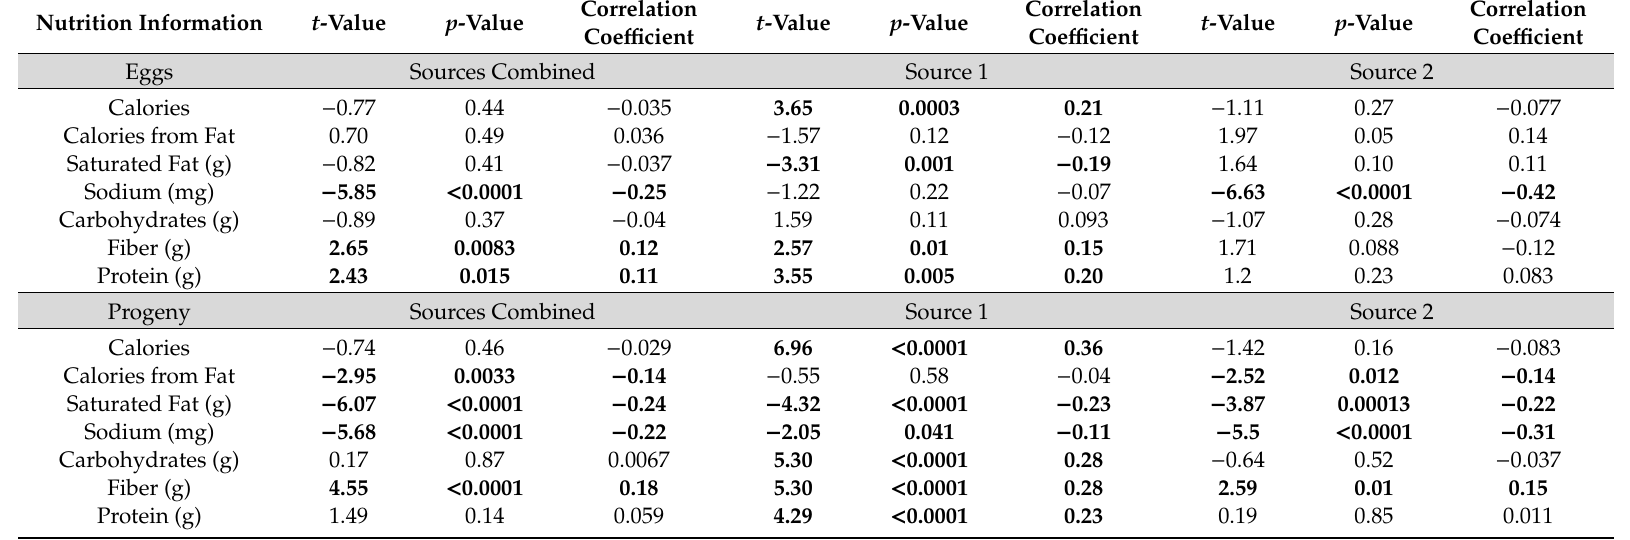
Table 4. Pearson correlations of nutrition information from flour packaging and egg and progeny counts. Bolded text within the table represents significant correlations between eggs or progeny counts and the nutrition